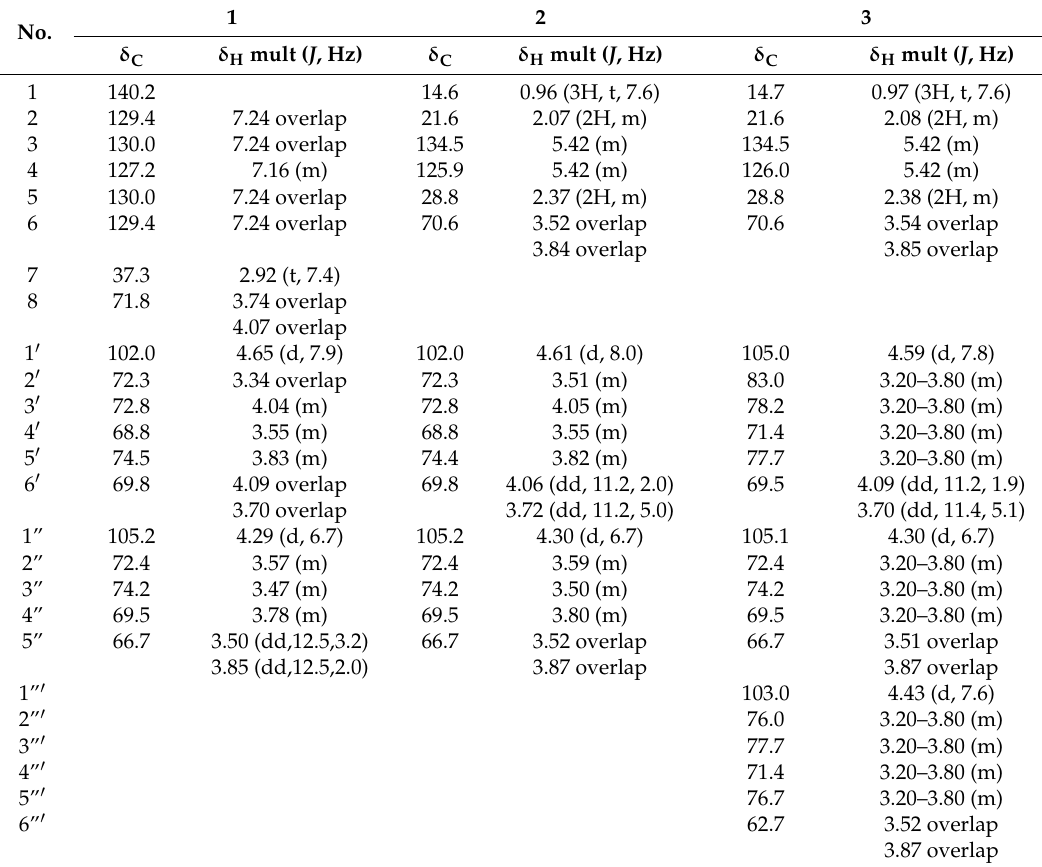
Table 1. 1 H- and 13 C-NMR Data of 1 – 3 (CD 3